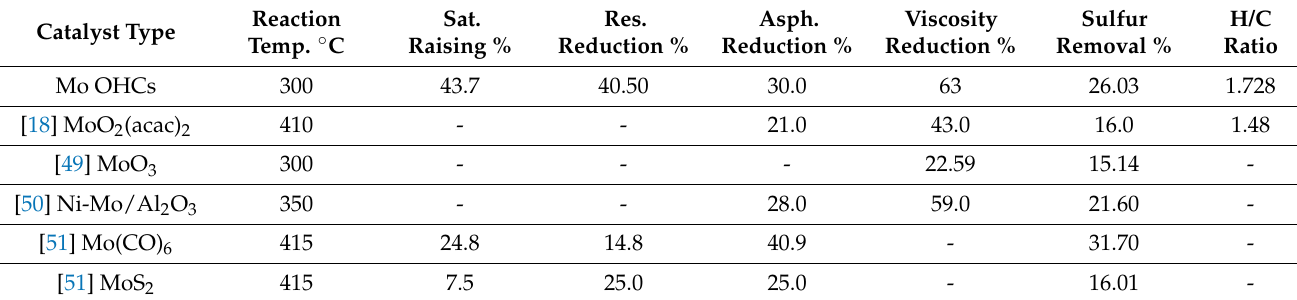
Table 6. Comparative analysis of the results of different studies based on